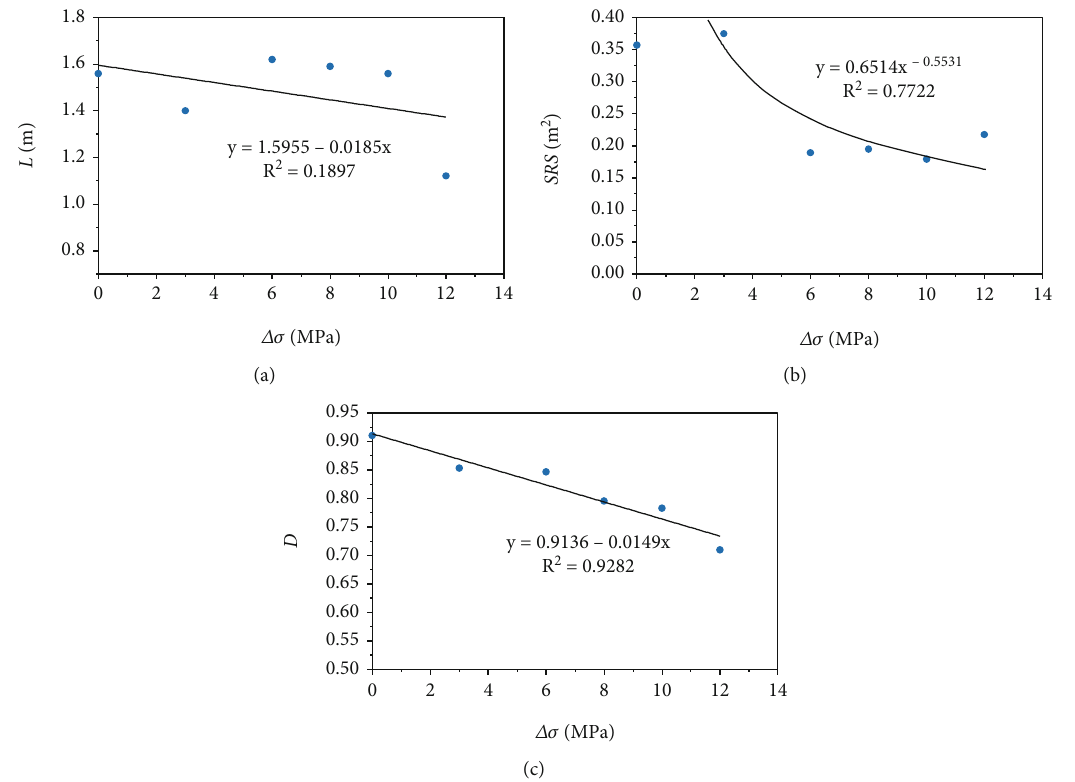
Figure 20: Geometric parameters of HF under di ff erent horizontal stress di ff